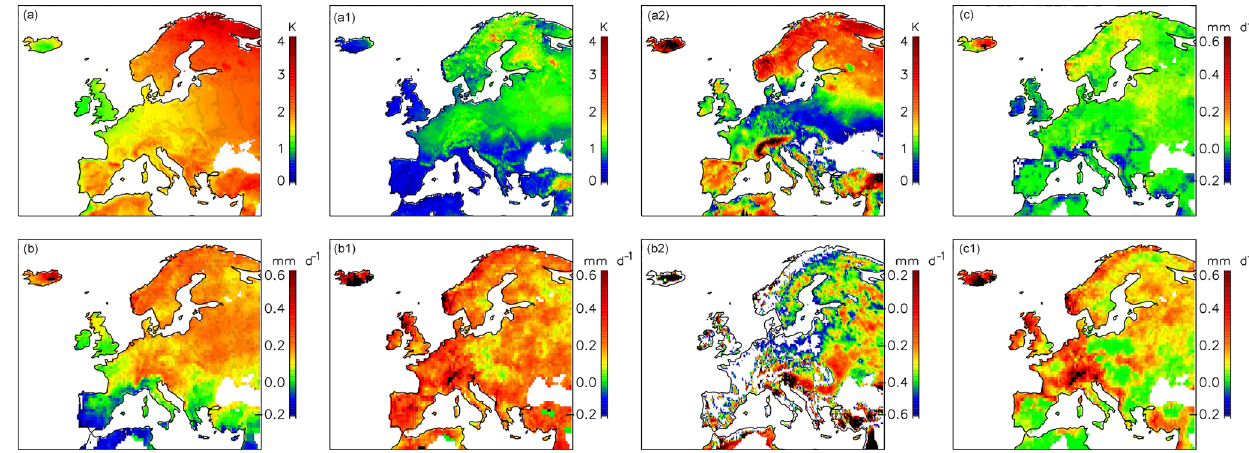
Figure 4. Predicted changes in mean annual temperature (a) average annual precipitation (b) and runoff (c) contrasted by their respective future climate bias-corrected spread ( a1 , b1 , c1 respectively) and present climate bias-correction patterns for temperature and precipitation only ( a2 , b2 respectively).